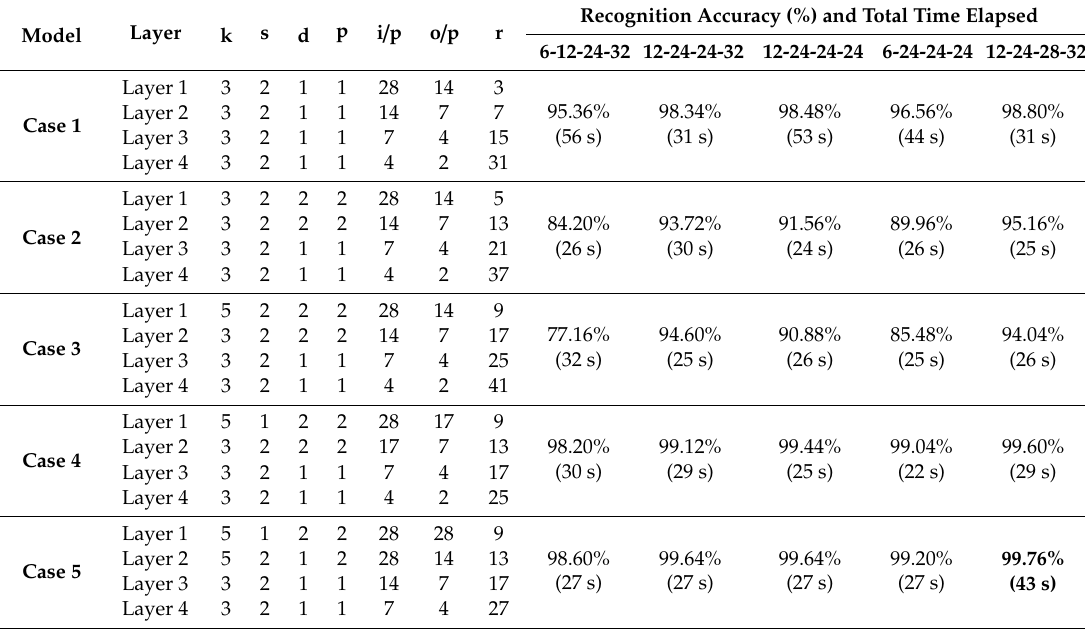
Table 3. Configuration details and accuracy achieved for convolutional neural network with four layers.